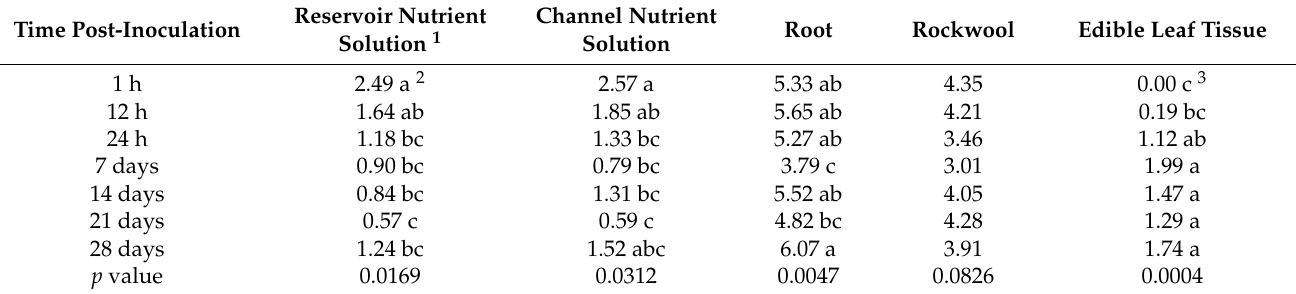
Table 3. Survival of Listeria monocytogenes (ATCC 19111) following the inoculation of the nutrient solution, simulating an extreme event, in the reservoir and the channels, root, rockwool, and edible leaf tissue over a 28-day growth